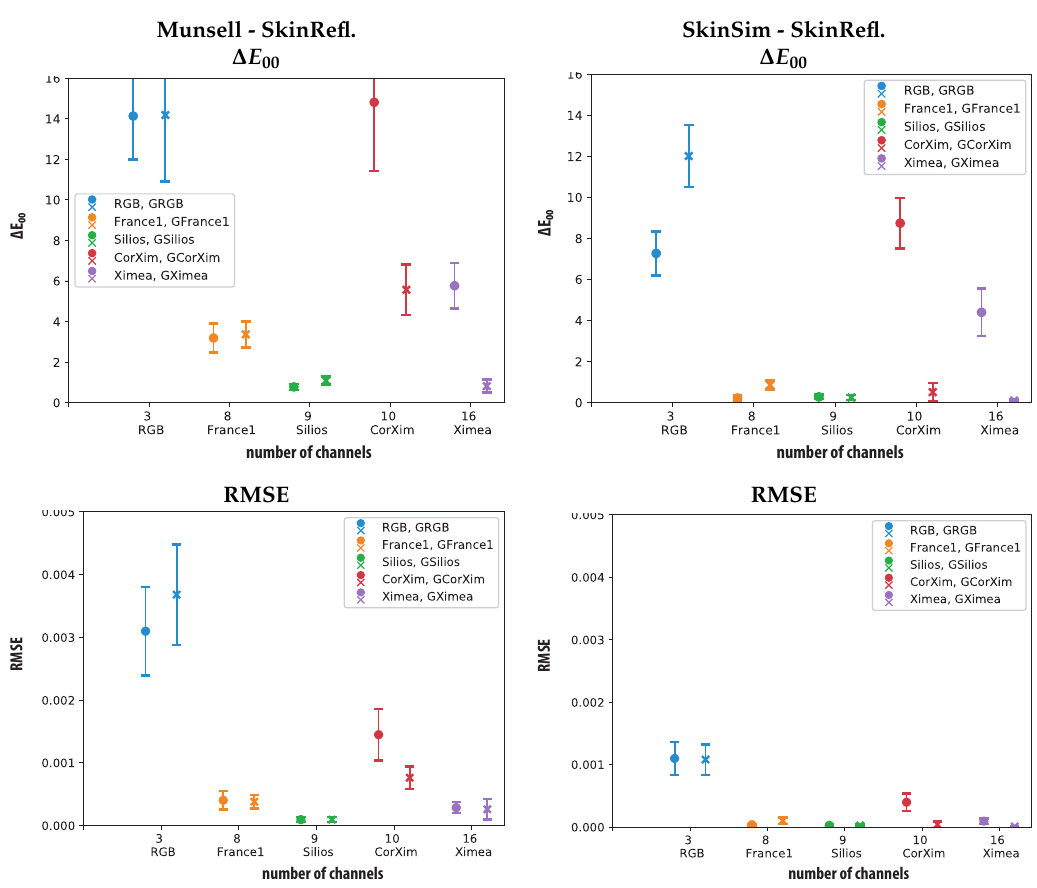
Figure 6. Resulting metrics of ∆ E 00 (D65, CIE 2 ◦ 1931) ( top ) and RMSE calculated between reconstruction and training ( bottom ). All Sensors, Munsell set ( left ) and Skin Simulation set ( right ) as training including standard deviation of the resulting data. For all graphs, the filled “o” represents the original sensor and the “x” represents the